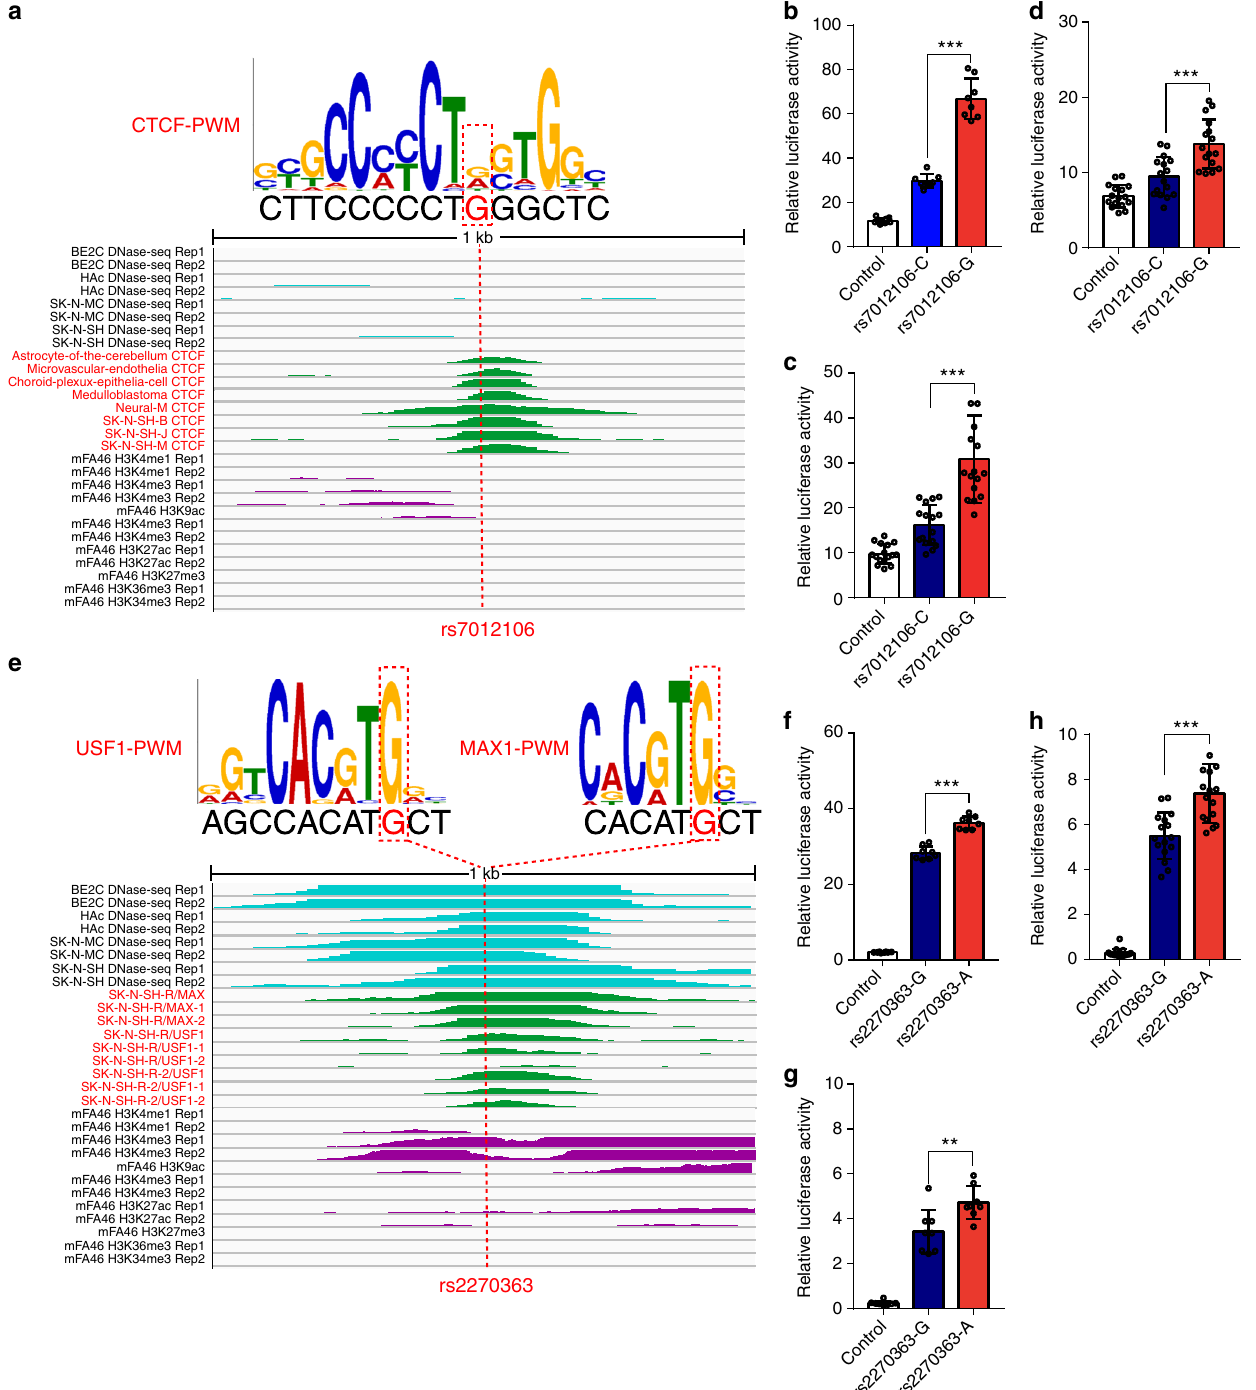
Fig. 6 Disruption of CTCF, USF1 and MAX1 binding by schizophrenia risk single-nucleotide polymorphisms (SNPs; rs7012106 and rs2270363). a